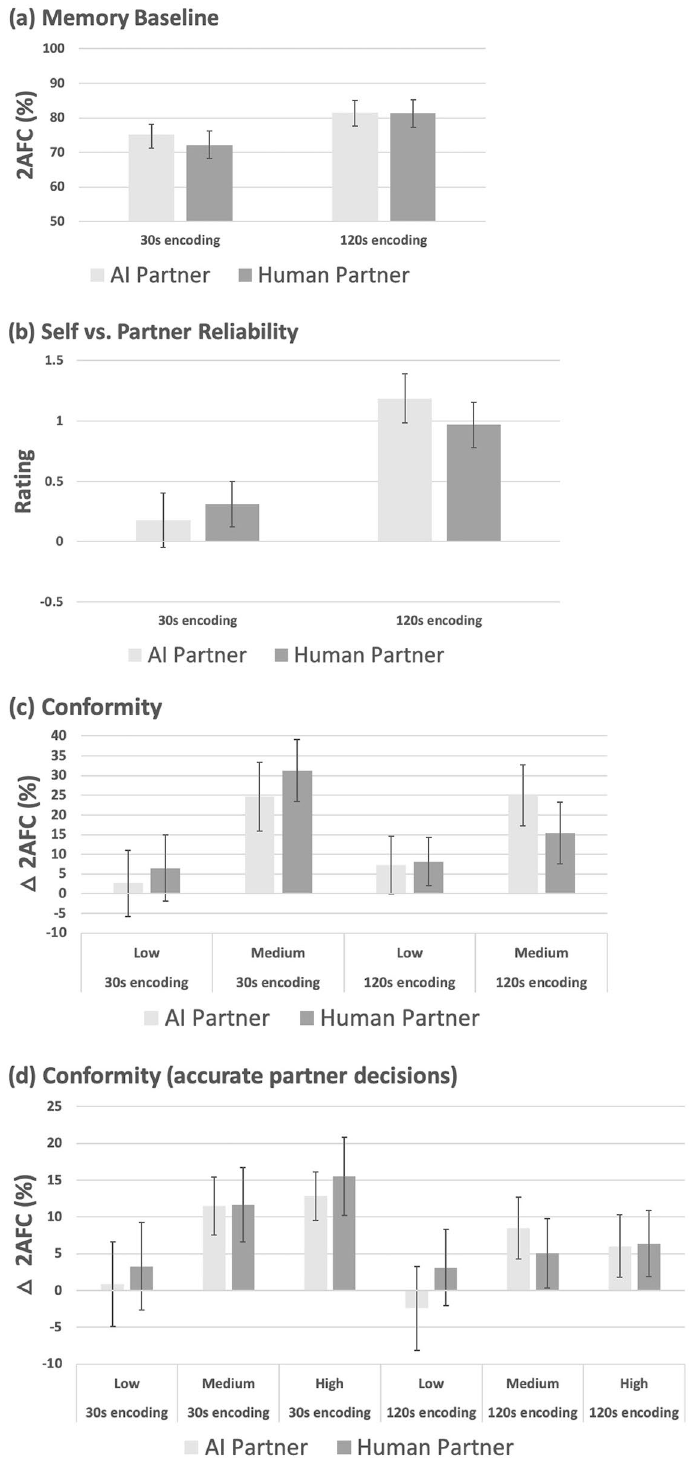
Figure 3. Data for Experiment 3 (Objective-accuracy effects). ( a ) Baseline 2AFC performance (± 95% CI) in the AI (light-grey) vs. human (dark-grey) groups, according to viewing time at encoding (30 s vs. 120 s). ( b ) Relative reliability ratings (± 95% CI) for participants own memory vs. AI or human partner, following 30 s vs. 120 s viewing time at encoding. ( c ) Change in 2AFC performance ( △ 2AFC, ± 95% CI) induced by conformity to accurate minus errant AI vs. human partner decisions at medium vs. low likelihood, following 30 s vs 120 s encoding of images. ( d ) Baseline-adjusted conformity-induced change in 2AFC performance (± 95% CI), for accurate AI vs. human partner decisions about image content following 30 s vs. 120 s